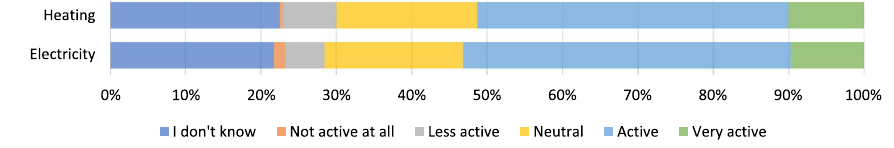
Fig. 4 Students’ believes on university energy